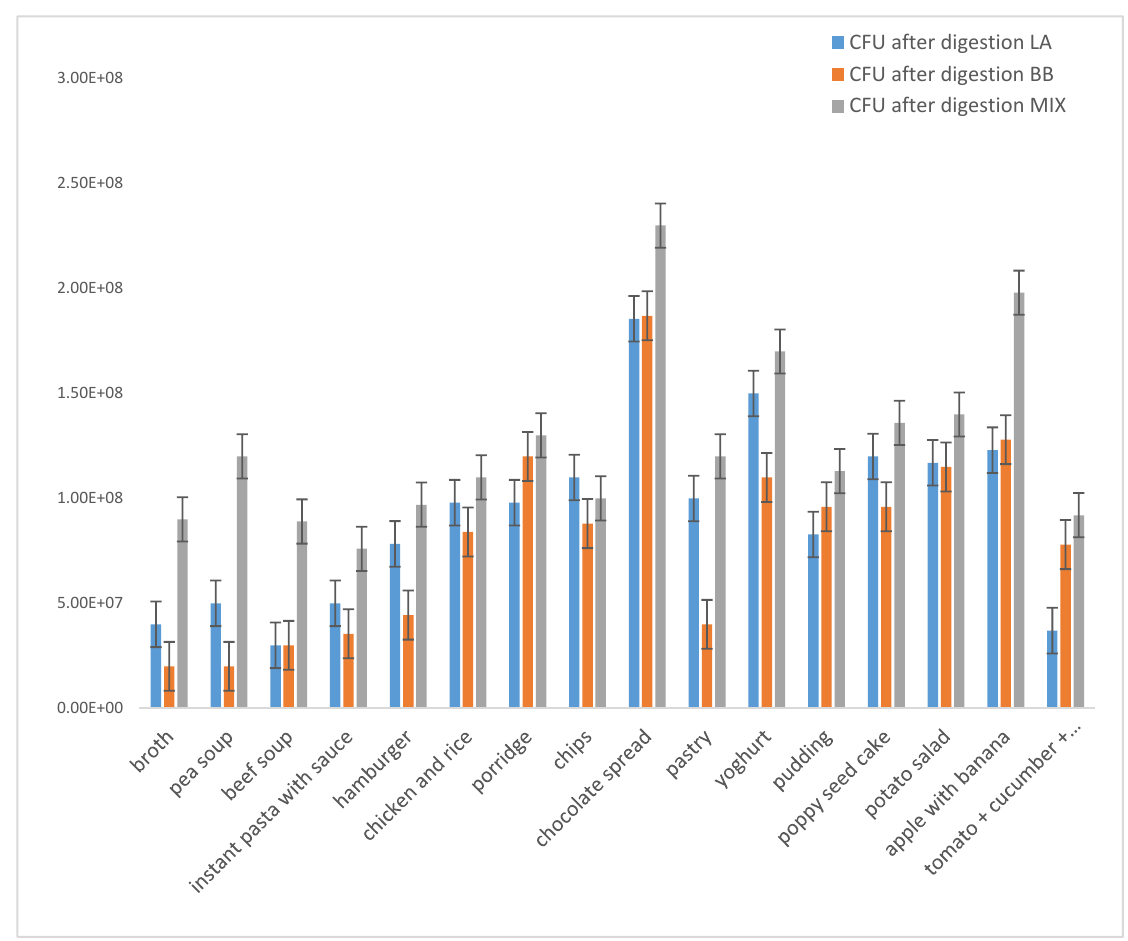
Figure 6. The influence of different types of food and the type of probiotic on the number of viable cells after model digestion (CFU/mL): comparison of monocultures Lactobacillus acidophilus (LA) and Bifidobacterium breve (BB) and mixed probiotic culture (MIX).